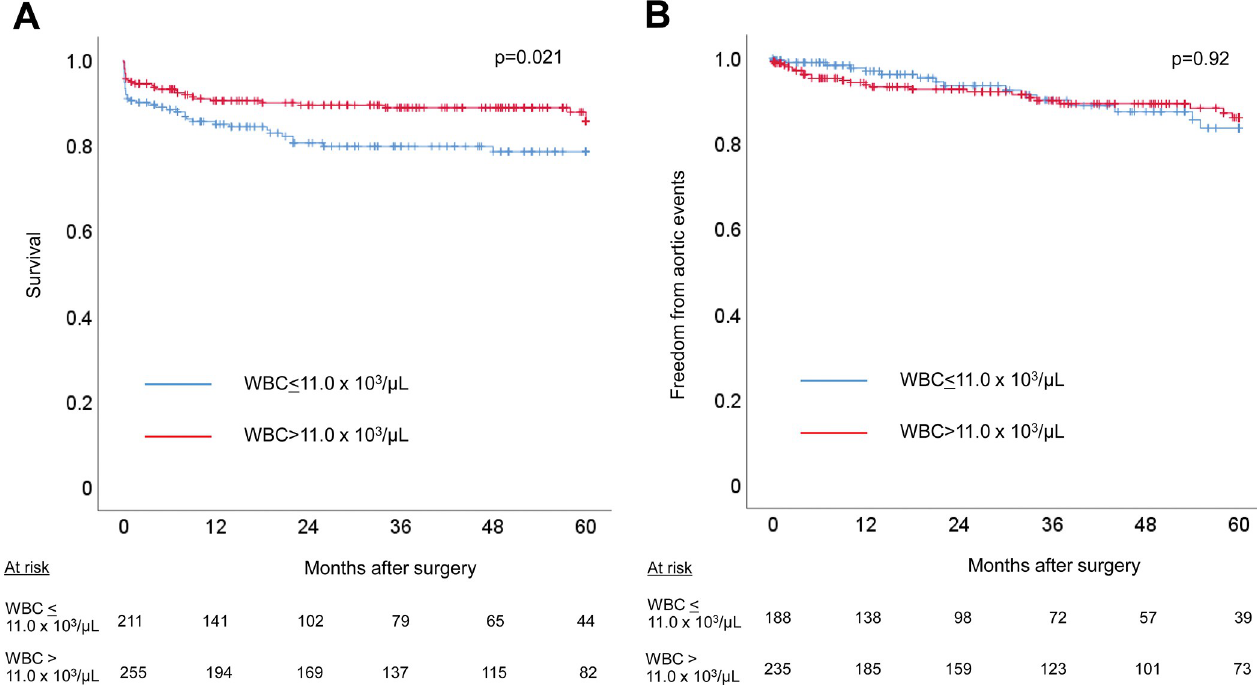
Fig 4. Kaplan-Meier curves of (A) cumulative survival of ATAAD patients, per WBC count ( � 11.0 x 10 3 / μ L or > 11.0 x 10 3 / μ L) and of (B) freedom from aortic events after discharge, per WBC count ( � 11.0 x 10 3 / μ L or > 11.0 x 10 3 / μ L). Probability values were obtained by log-rank test. ATAAD, acute type A aortic dissection; WBC, white blood